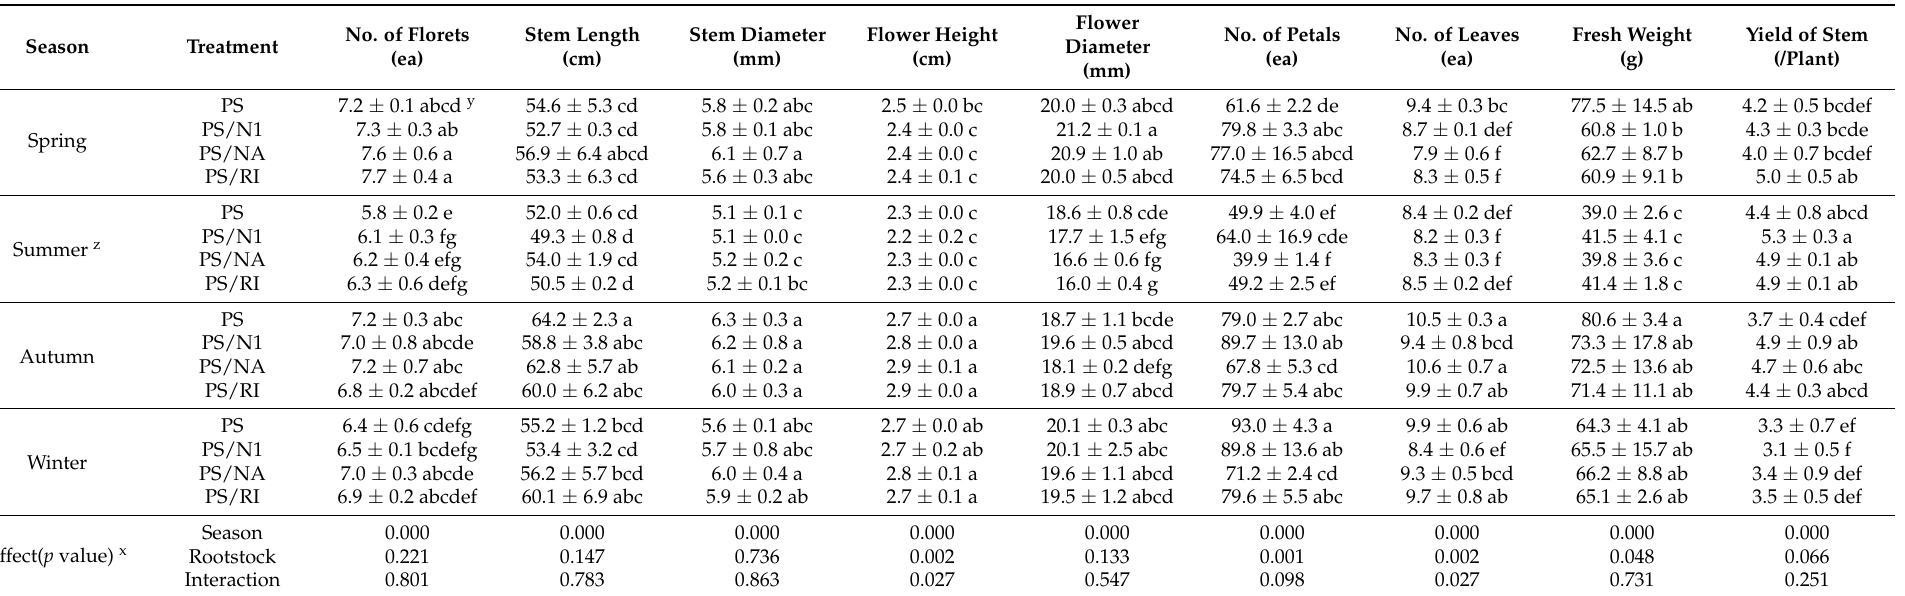
Table 2. The quality and yield of cut roses for Rosa hybrida cv. Pink Shine (PS) and PS grafted onto Rosa multiflora cv. Hort. No. 1 (PS/N1), PS grafted onto Rosa canina cv. Natal brier (PS/NA), and PS grafted onto Rosa indica cv. Major (PS/RI) in four